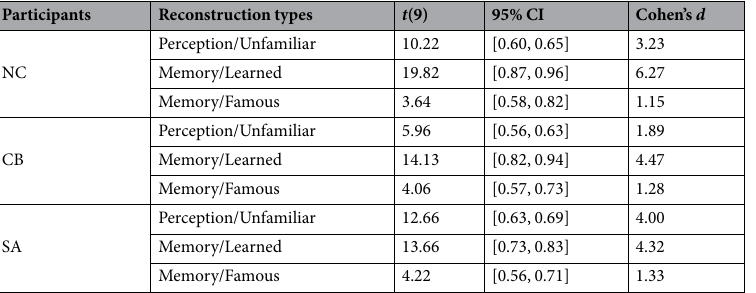
Table 2. Evaluation of reconstruction results across independent participants (Experiment 2). Note: CI = confidelnce